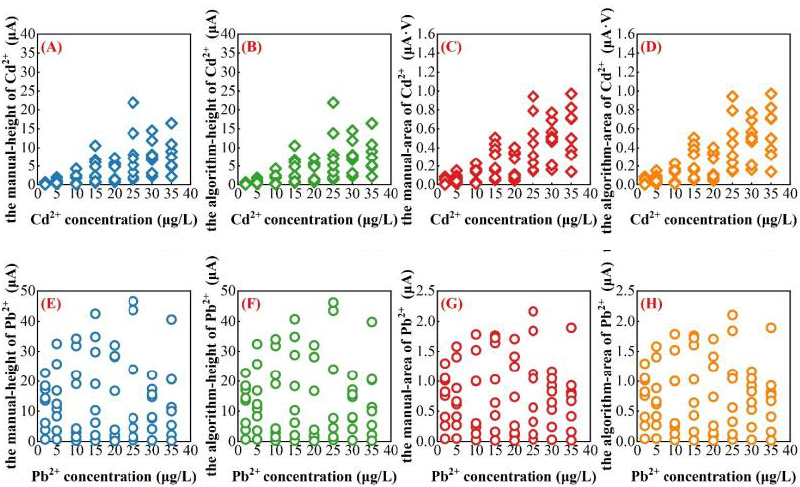
Figure 5. I manu ( A , E ), I algo ( B , F ), A manu ( C , G ), and A algo ( D , H ) of Cd 2+ and Pb 2+ acquired from the SWASV curves of 64 experiments. (Diamond scatters represent the peak heights or peak areas of Cd 2+ , circular scatters represent the peak heights or peak areas of Pb 2+ . Blue scatters represent the I manu , green scatters represent the I algo , red scatters represent the A manu , orange scatters represent the A algo ).